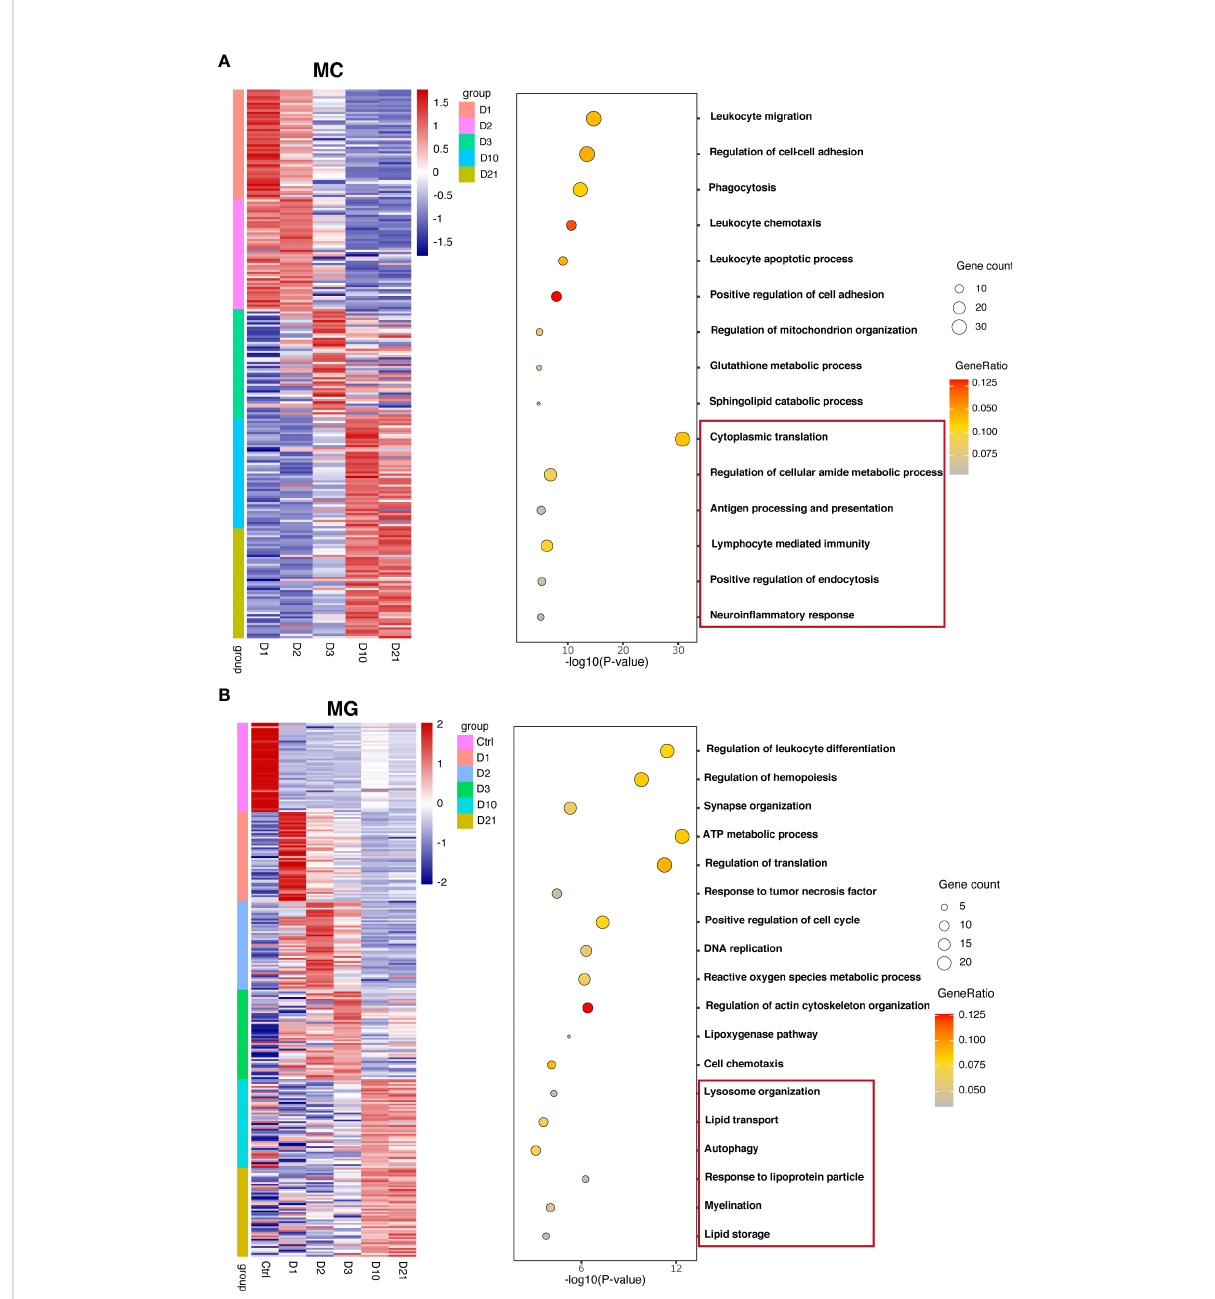
FIGURE 2 Unique marker genes and related gene ontology (GO) of biological processes in macrophages (A) and microglia (B) collected at different time